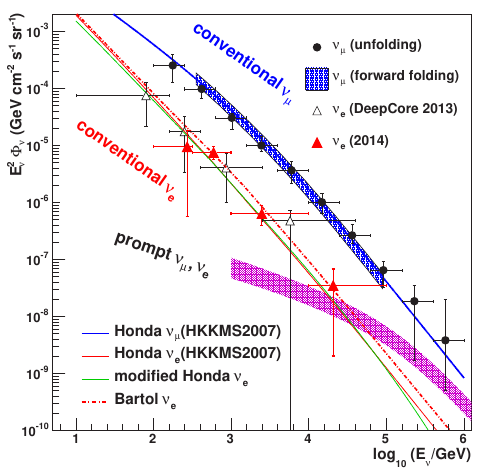
Figure 2. The atmospheric ν e flux results by IceCube shown with the flux predictions. Figure is taken from